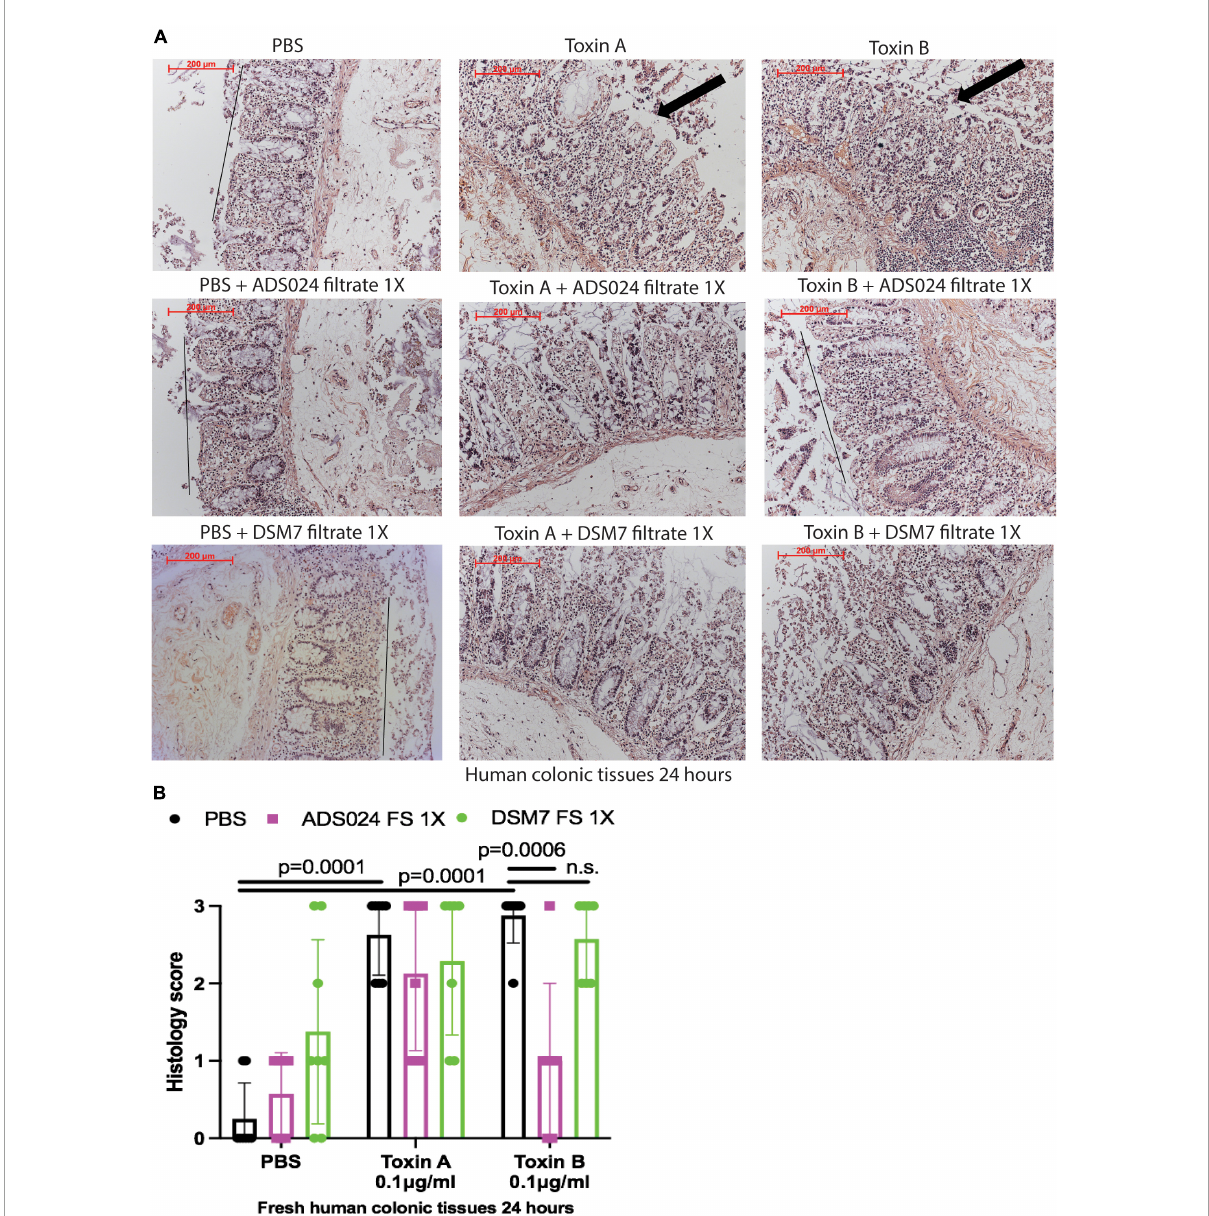
FIGURE2 ADS024 sterile filtrate reduced toxin B-mediated epithelial injury in fresh human colonic explants. Fresh human colonic explants were placed in serum-free RPMI1640 media with PBS or 0.1% v/v of ADS024 and DSM7 sterile filtrate (FS) at 1X. Thirty minutes later, toxin A and toxin B (0.1 µ g/ml) were added and further incubated for 24 h. (A) H&E-stained images at 100X magnification. Black lines indicated the integrity of the top lining of colonic mucosa in PBS control and toxin B- and ADS024 filtrate-treated groups. Arrows indicated toxin-mediated disruption of mucosal integrity and thickness. (B) Histology scores for epithelial injury (0–3). ADS024 sterile filtrate 1X reduced toxin-B mediated epithelial injury. Results were pooled from samples from 10 patients. One-way ANOVA tests were used.